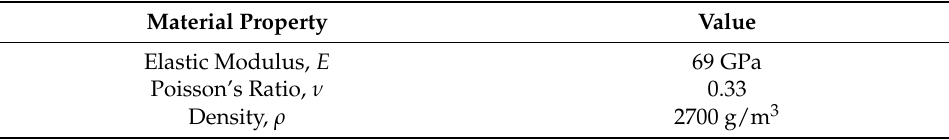
Table 1. Material properties of 6061-T6 Aluminum